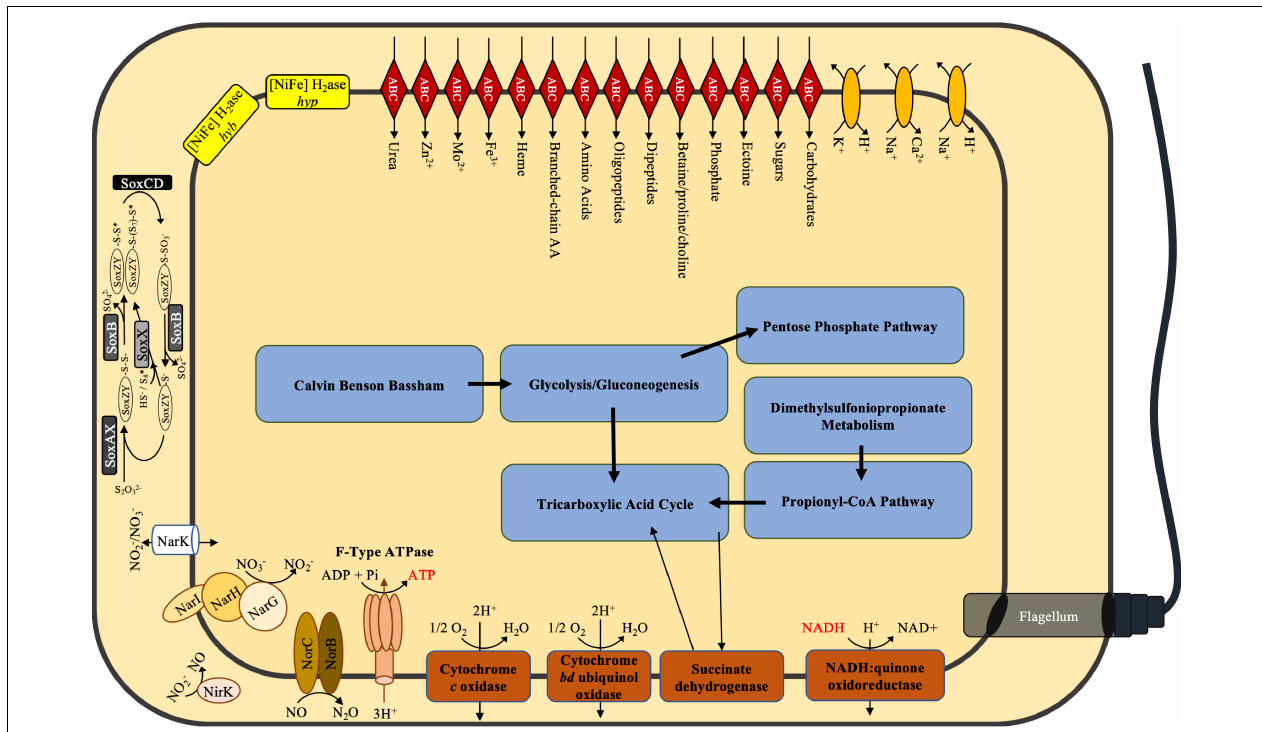
FIGURE 1 | Simplified genome-resolved central metabolic model for Thioclava electrotropha ElOx9 T . See Supplementary Table 2 for a list of genes comprising central metabolic pathways.